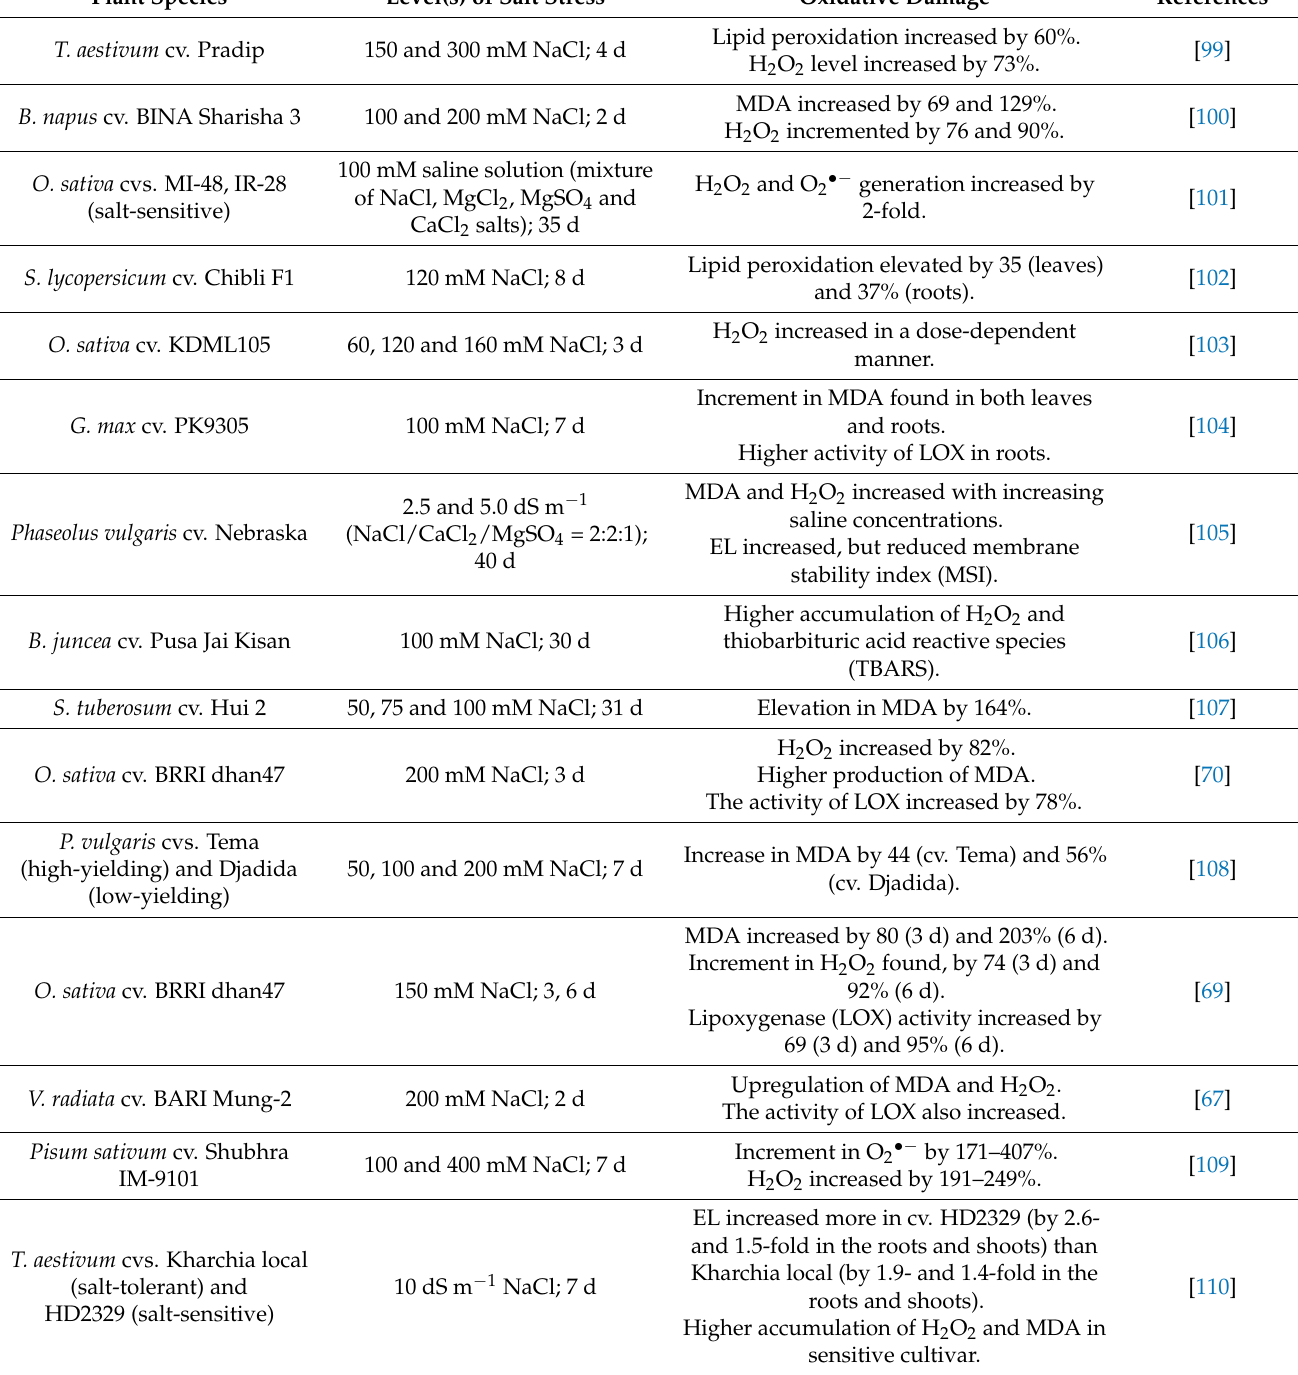
Table 1. Oxidative stress in plants under